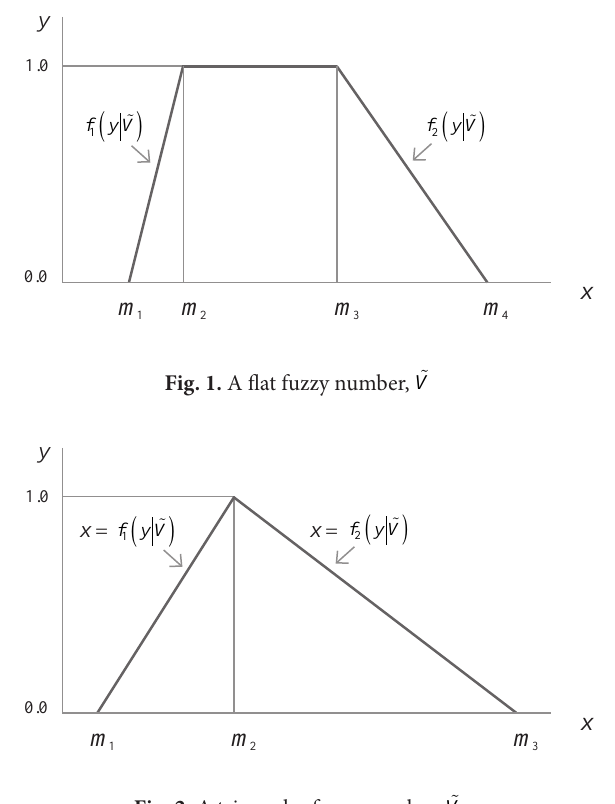
Fig. 2. A triangular fuzzy number, 